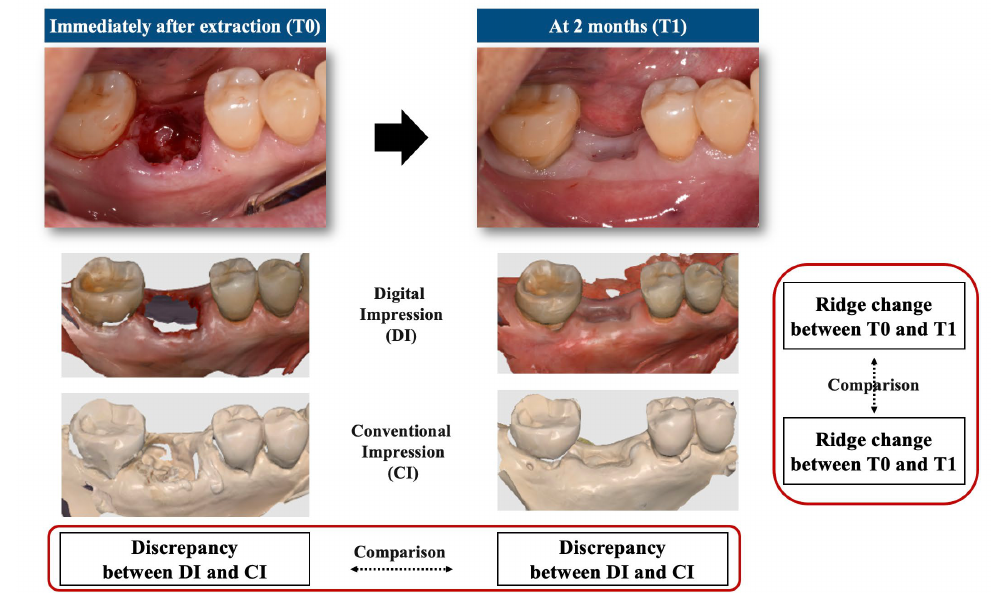
Figure 1. Flow and design of the study. T0: immediately after tooth extraction, T1: 2 months after extraction.